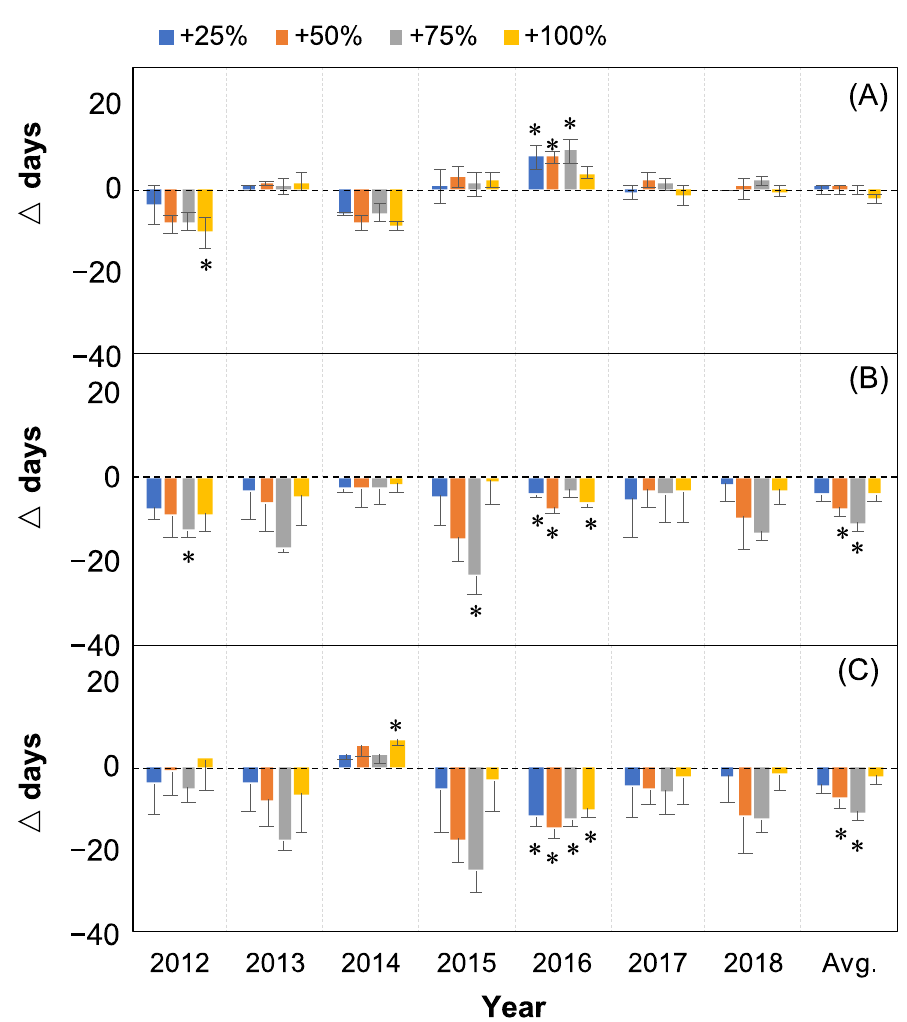
Figure 2. Relative changes compared to control ( △ days; mean ± SE) in the onset ( A ), end ( B ), and duration ( C ) of seed release in Nitraria tangutorum after the water addition treatments (+25%, +50%, +75%, and +100%) compared with the control. Positive and negative values represent relatively de- layed or prolonged and advanced or shortened days, respectively. Avg. represents the average values from 2012 to 2018. The asterisk “*” marks indicate significant differences between the treatments compared with the